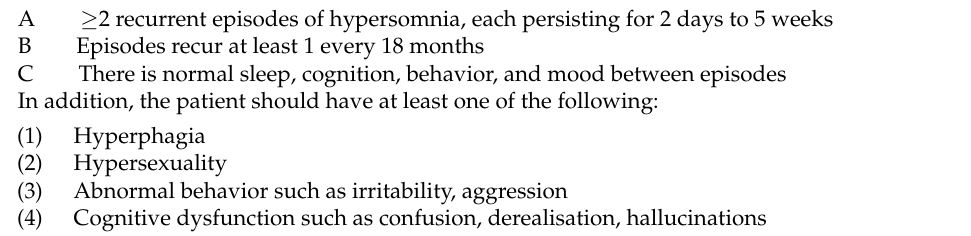
Table 1. ICSD-3 criteria for Kleine–Levin